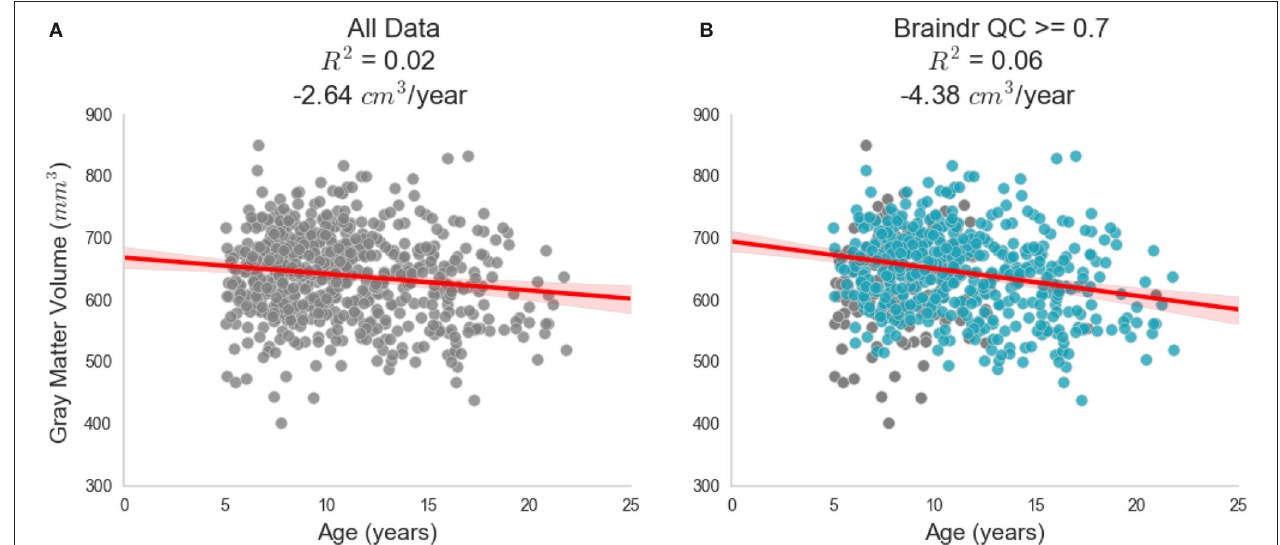
FIGURE 4 | Impact of quality control on effect size estimates. Results of quality control on the inferred association between gray matter volume and age during development. (A) Shows the relationship when all data is used in the ordinary least squares (OLS) model. (B) Shows the new OLS model when data is thresholded by the deep learning model’s predicted braindr rating at 0.7. The effect size nearly doubles when QC scores are taken into account. See results.braindr.us for an interactive version of this